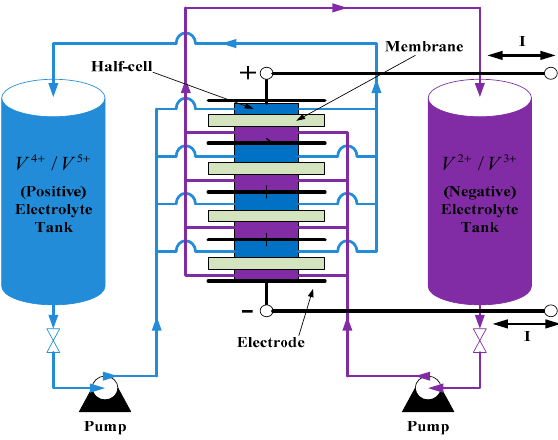
Figure 1. The system architecture of a vanadium redox flow battery (VRFB) [19].